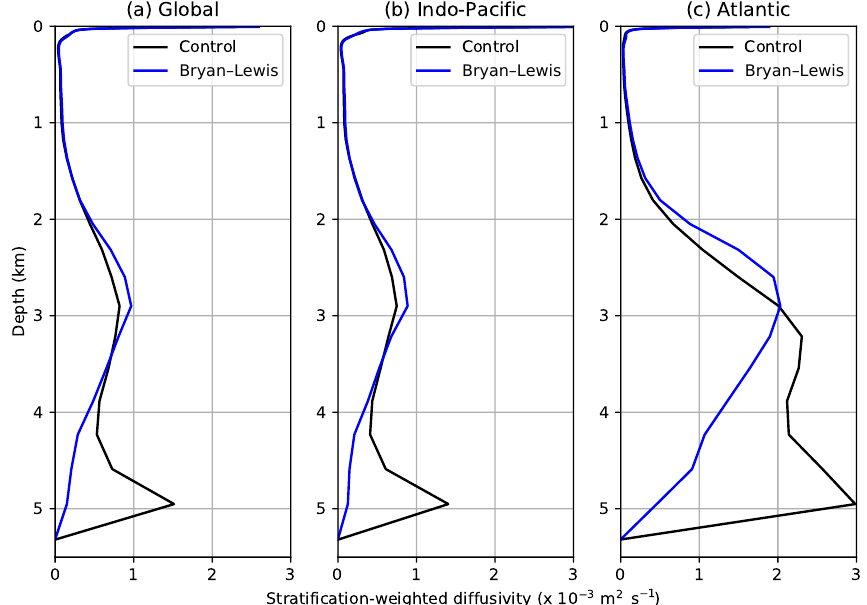
Figure 9. Stratification-weighted diffusivity (see text) computed over (a) global, (b) Indo-Pacific and (c) Atlantic domains for the control (800ppm) and Bryan–Lewis diffusivity experiments.